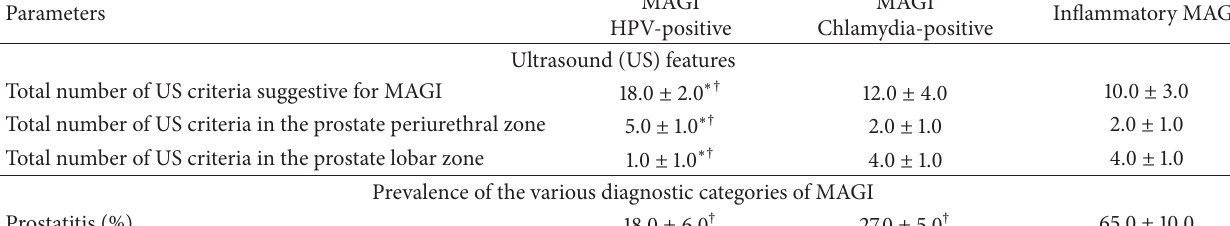
MAGI MAGI Inflammatory MAGI HPV-positive Chlamydia-positive Ultrasound (US) features